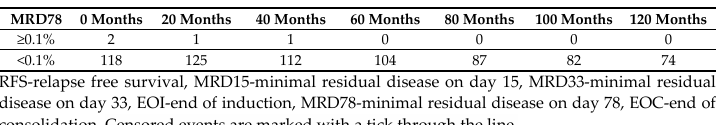
consolidation. Censored events are marked with a tick through the line. Figure 3. Relapse-free survival (n-140), according to MRD response ( ≥ 0.1% vs. <0.1%) on day ( A ) day 15 (TP1), ( B ) day 33 (TP2), ( C ) day 78 (TP3). Table 6. Outcomes by MRD result: MRD ≥ 0.1% vs. MRD < 0.1% on day 15 (TP1), 33 (TP2) and 78 (TP3). Figures 4 and 5 present the results by the kinetics of the early blast clearance between day 15 and day 33/EOI. Patients with negative MRD on days 15 and 33 had a higher 5-year Cancers 2022 , 14 , x FOR PEER REVIEW 14 of 21 OS rate of 100% ( p = 0.002) and RFS rate (97.6%, p < 0.001) than those with positive ( ≥ 0.01%) MRD at both time points (OS-77.8%, RFS-55.6%).